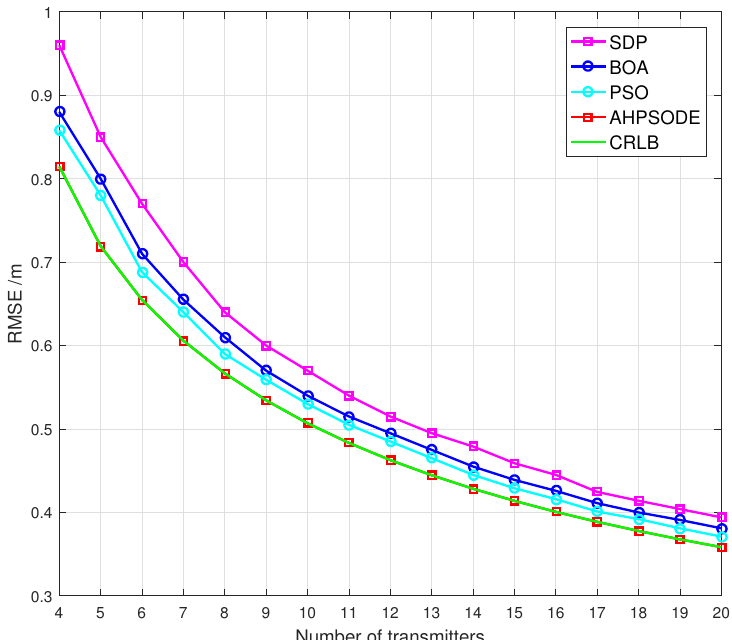
Figure 10. The RMSEs of the algorithms under consideration for σ 2 = 1 m 2 , as a function of the number of